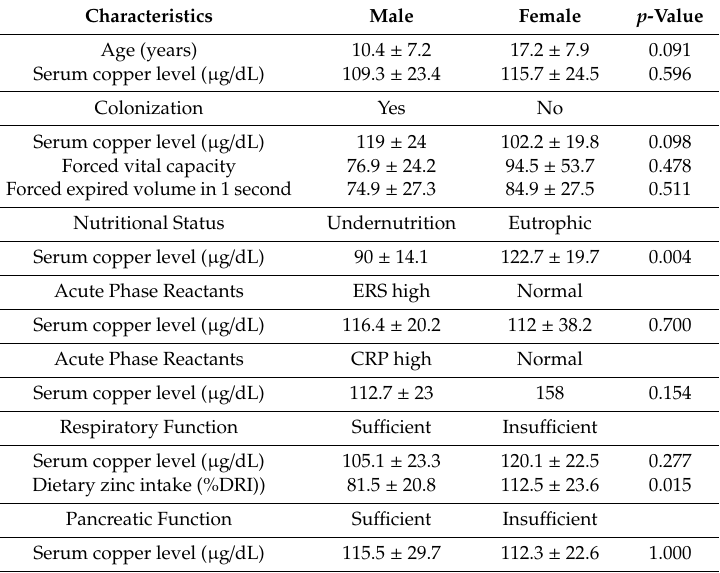
Table 2. Di ff erences between fibrosis cystic patients.